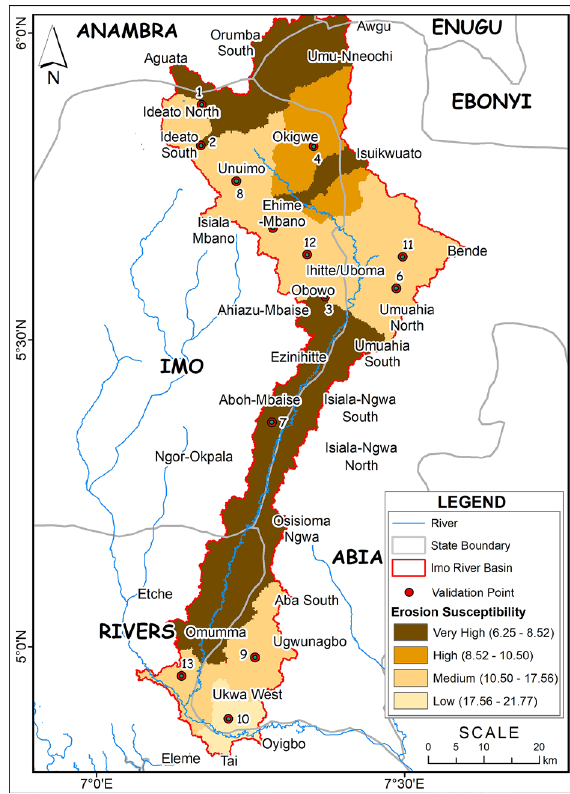
Fig. 6. Overlay of validation points on the erosion susceptibility